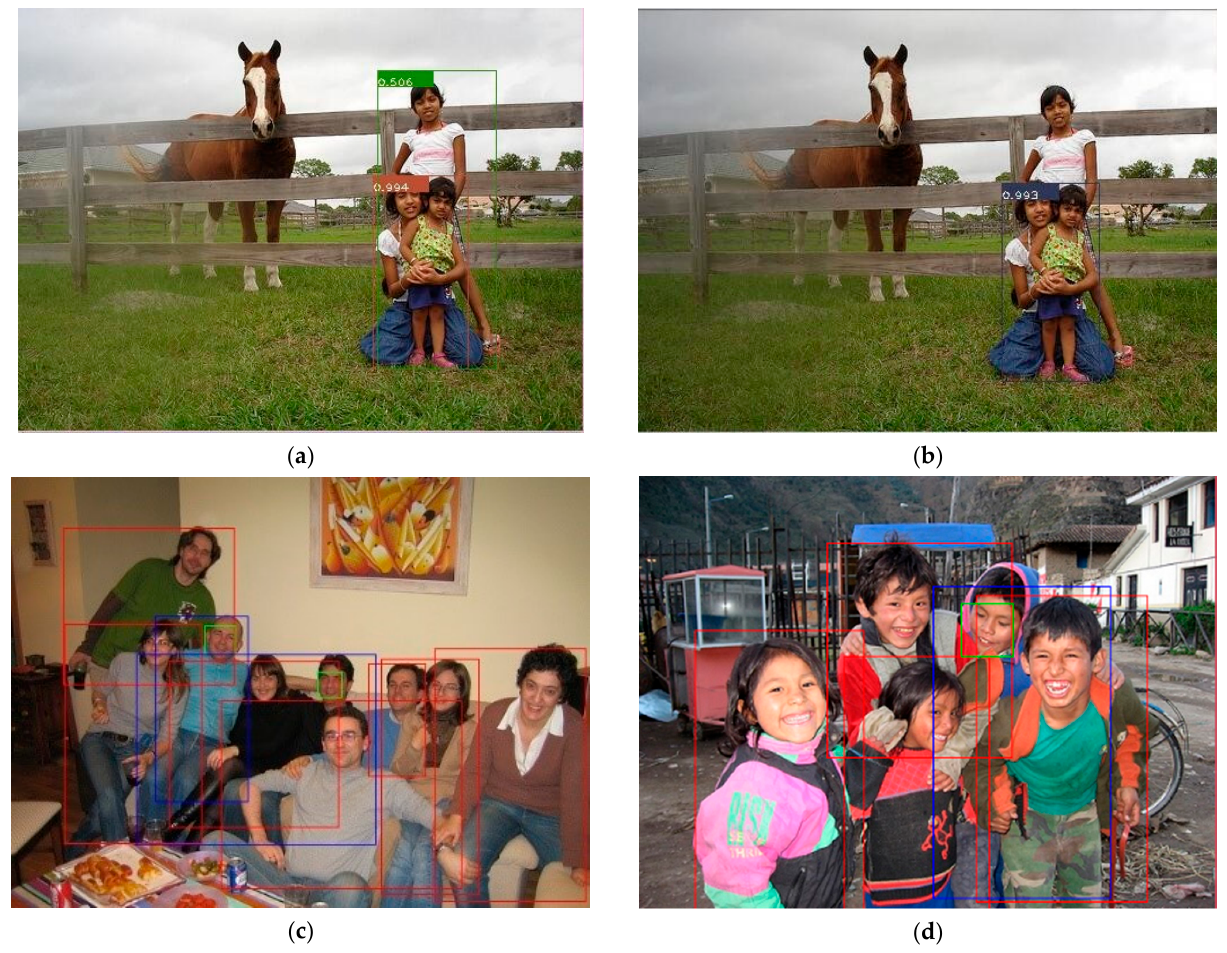
Figure 9. The improvement for YOLOv3 using Soft-NMS and the retrieval algorithm. ( a ) Detection using Soft-NMS; ( b ) detection using NMS; ( c ) detection using Soft-NMS and the retrieval algorithm; ( d ) detection using Soft-NMS and the retrieval algorithm.